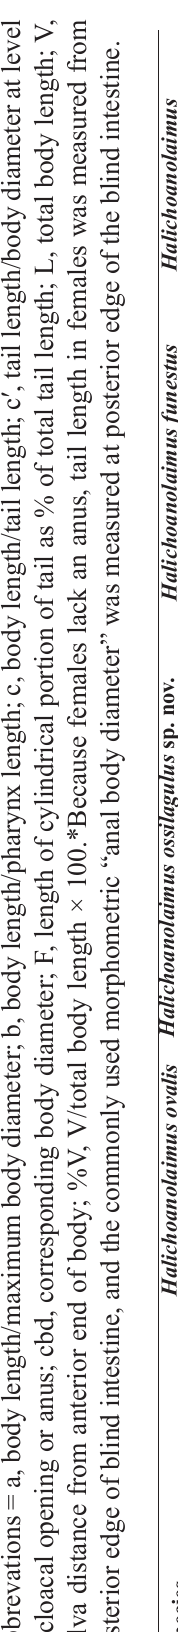
li a o v u s m a i o l n oa h li c a H e s ec i Sp